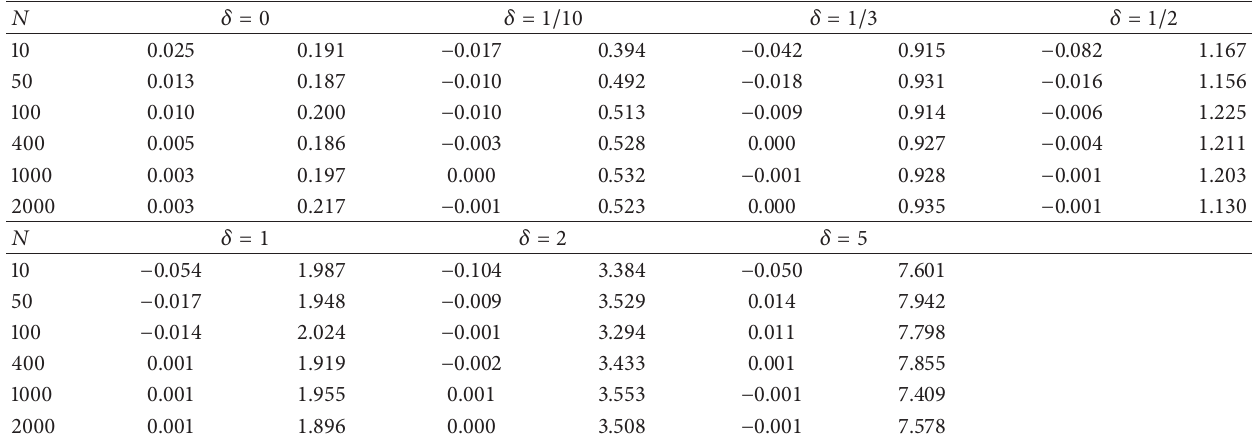
̂𝛿 Table 1: Finite sample properties of . For each 𝑁 , 𝛿 was estimated 𝑛 = 1 ,000 times from a random sample z ∼ Tukey’s ℎ . The left column MLE ̂𝛿 − 𝛿 ; each right column shows the root mean square error (RMSE) times √𝑁 for each 𝛿 shows bias, MLE